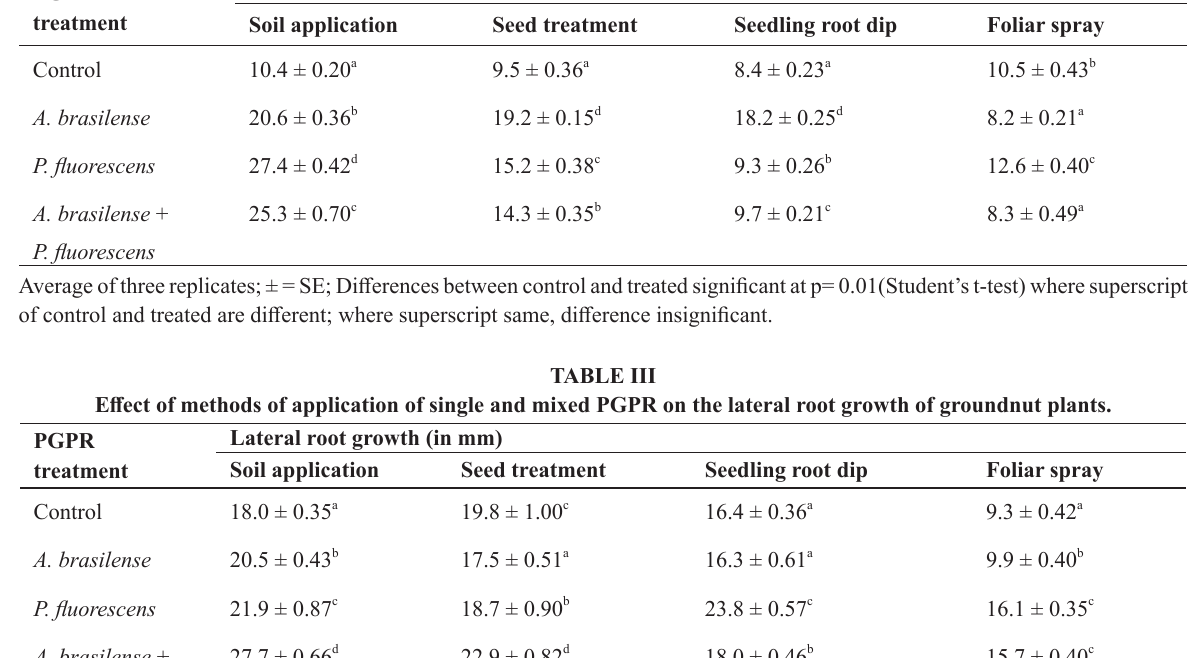
Effect of methods of application of single and mixed PGPR on the tap root growth of groundnut plants.